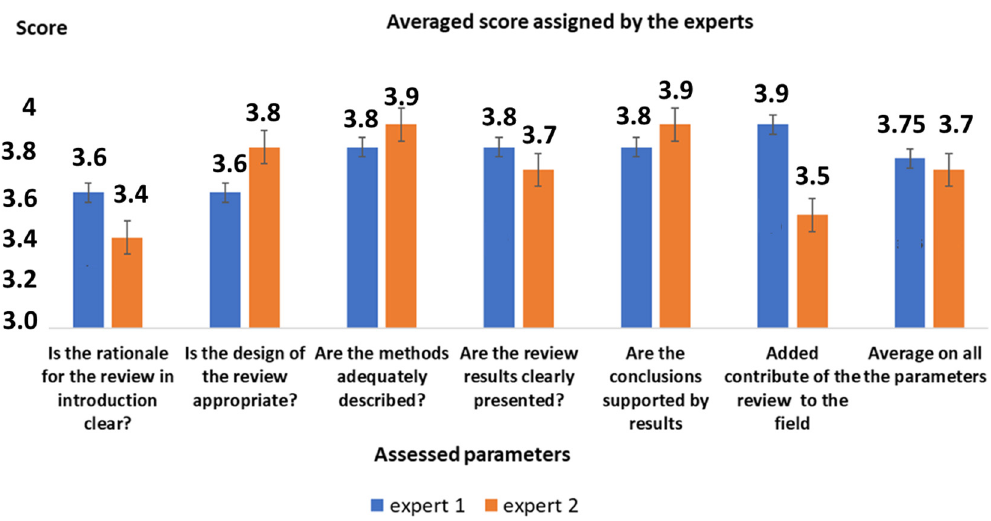
Figure 1. Output from the qualification process.